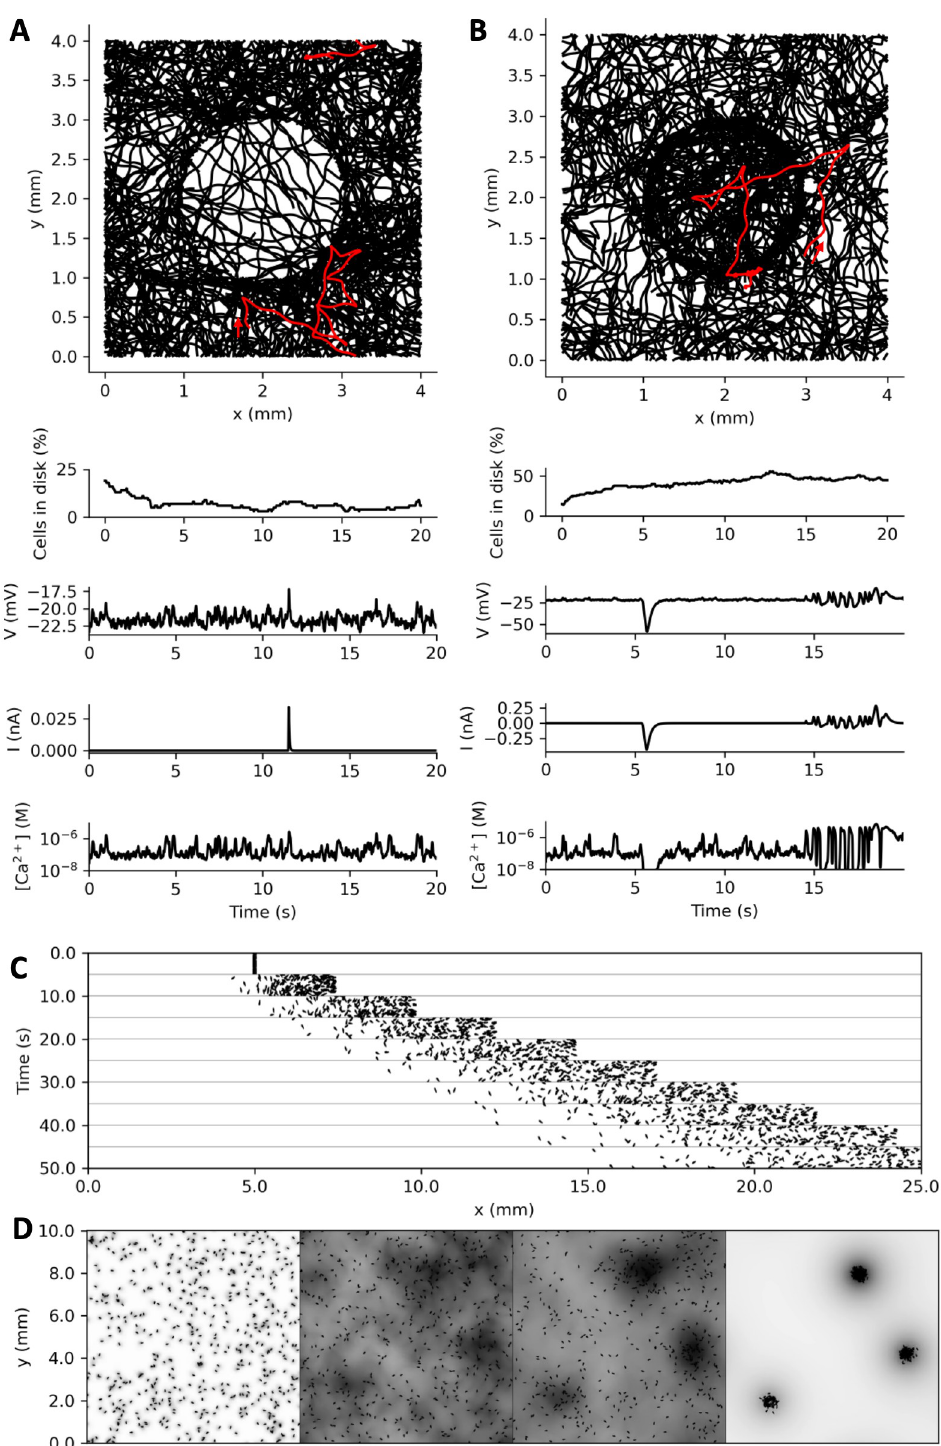
Fig 11. Closed-loop behavior of the Paramecium model. A, Top: trajectories of 100 models swimming for 20 s in a torus with a depolarizing circular stimulus, modelled as in Fig 10C. The proportion of cells in the disk quickly decays (below). Membrane potential, stimulus current, and intraciliary calcium concentration are shown for the trajectory highlighted in red, which does an avoiding reaction against the disk after a number of spontaneous avoiding reactions. B, 100 model trajectories with a circular stimulus triggering an adapting hyperpolarizing current. Organisms tend